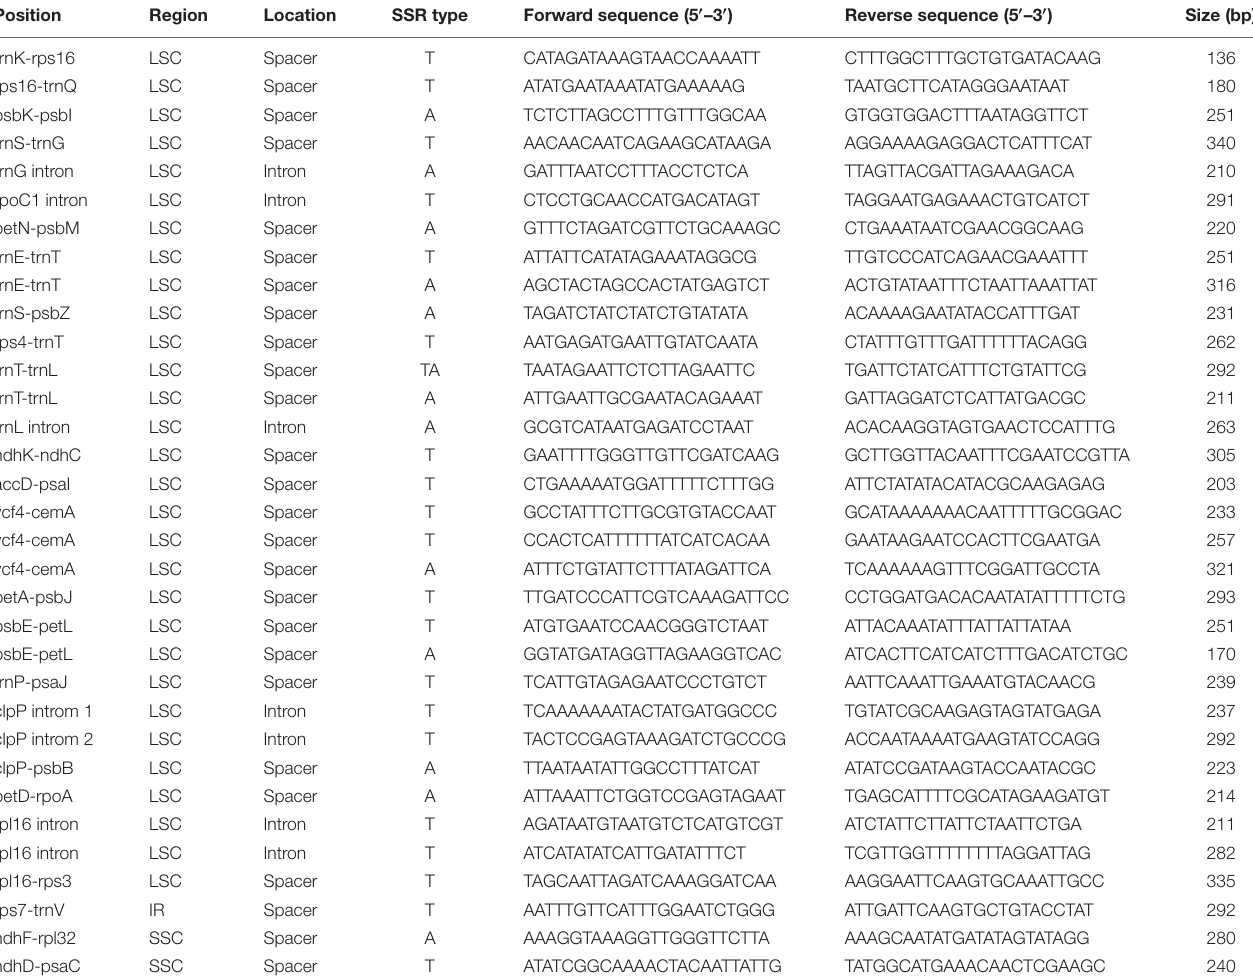
TABLE 2 | Polymorphic SSRs identified from in silico comparative analysis of 12 genotypes of B. sinensis plastomes.